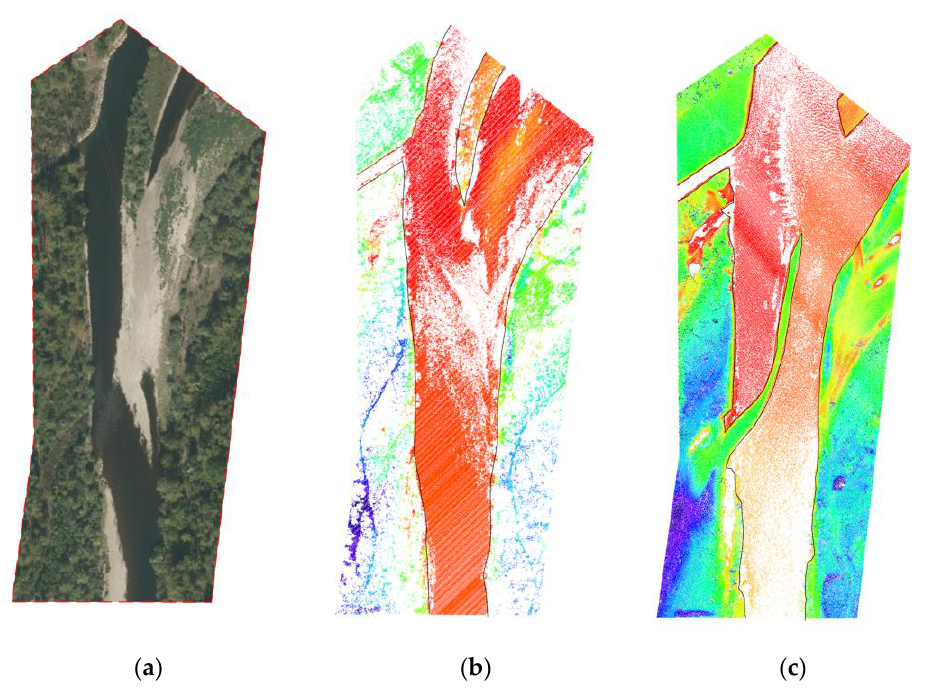
Figure 6. Change of the river bed in the period 2012 –2020 (Soła River, Poland) ( a ) orthophoto, ( b ) LiDAR 2020, ( c ) LiDAR 2012.